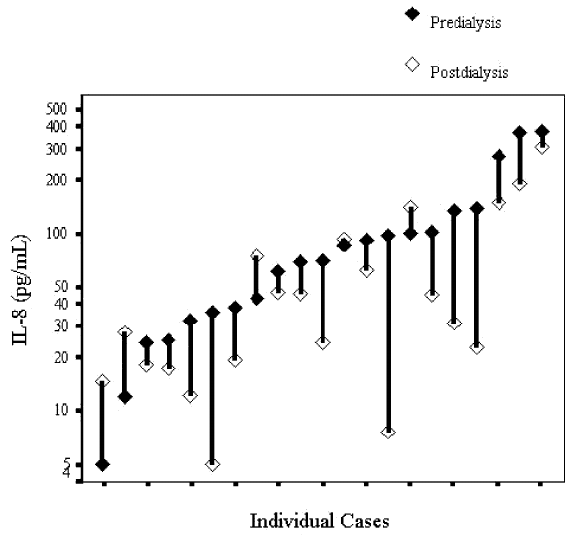
FIG. 1. Pre-hemodialysis and post-hemodialysis IL-8 concen- trations of the patients arranged according to the pre- hemodialysis IL-8 values in ascending order on a semi- logarithmic